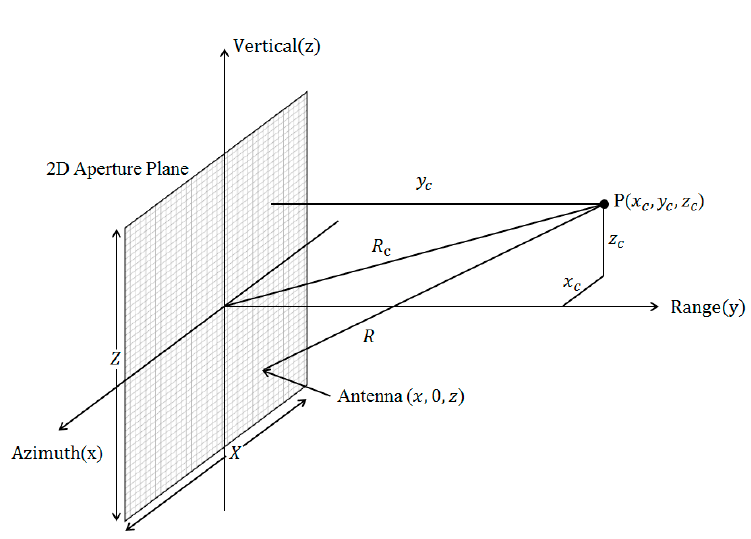
Figure 3. Geometry of GB-TomoSAR.